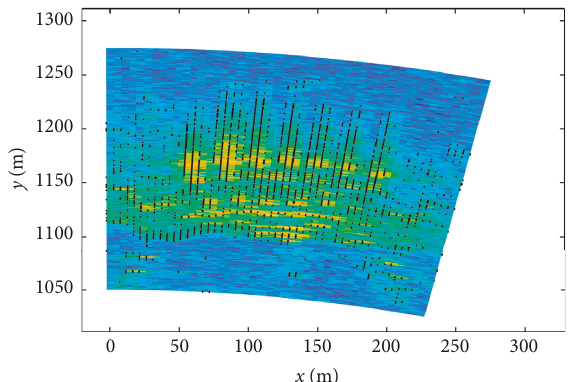
Figure 11: PS points extracted using the CPSS method (the black dots are PSs).